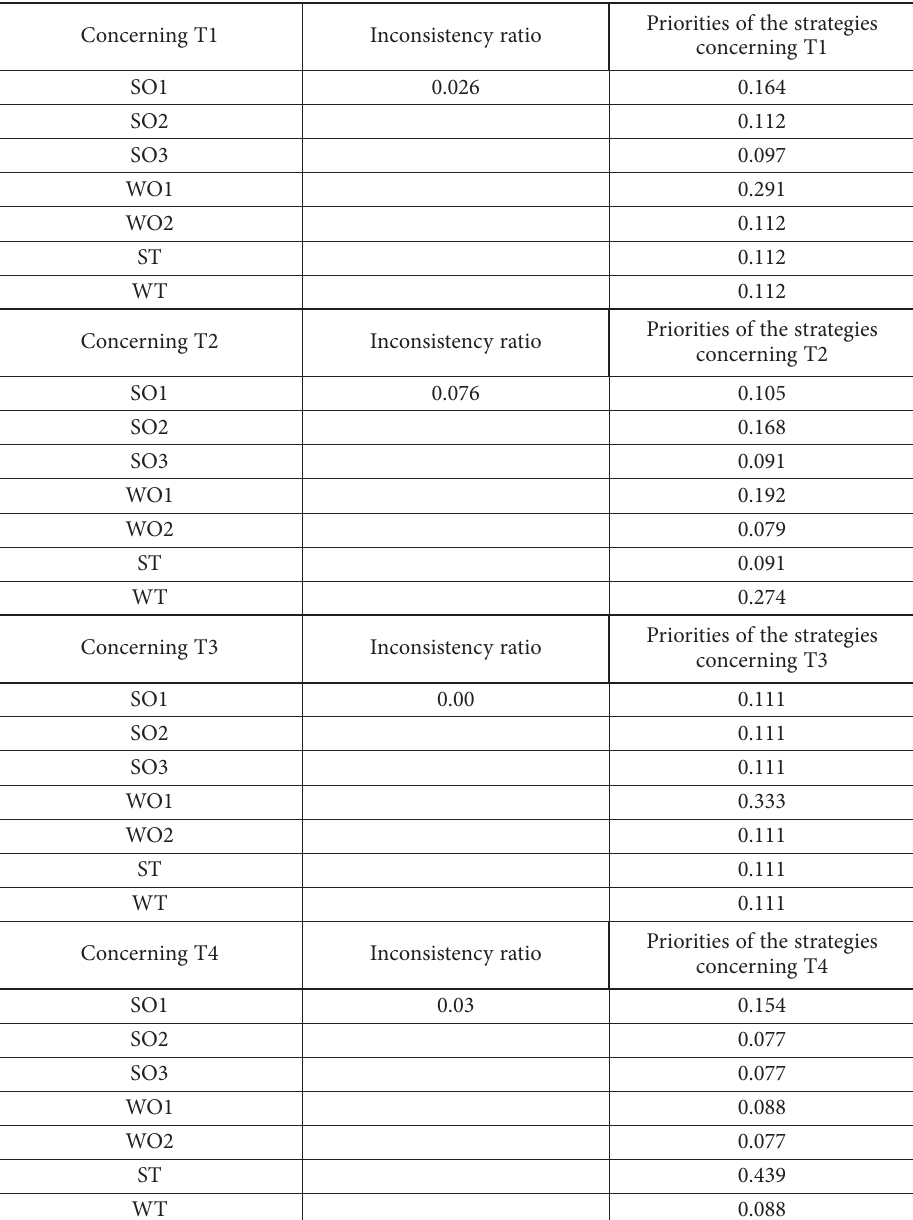
Table 12. Pair-wise comparisons of the strategies in relation to the threats Concerning